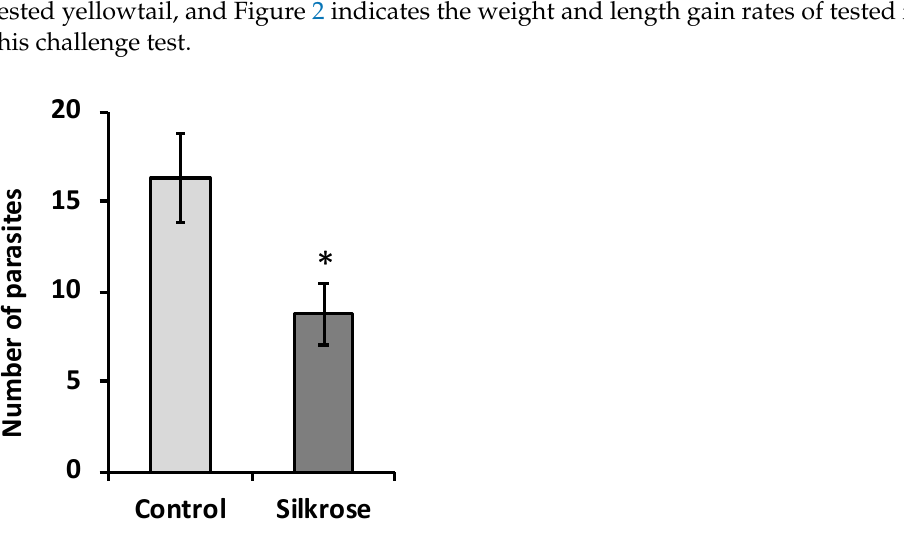
Figure 1. Effect of silkrose treatment on the number of parasites of Benedenia seriolae per individual yellowtail. Diet containing silkrose at a concentration of 0.1% was fed to yellowtail ( n = 10) for 10 days. Results are presented as mean ± standard error. Asterisk indicates statistically significant differences versus control group (* p < 0.05).